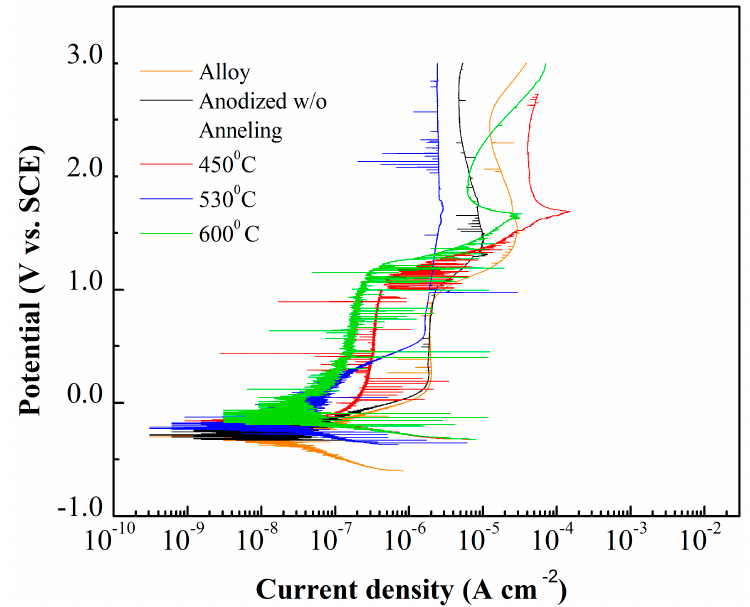
Figure 4. Polarization curves in 0.15 M NaCl + 0.03 M NaF solution at 25 °C, and − 0.8 V–3.5 V potential range and sweep rate 0.166 mV/s.